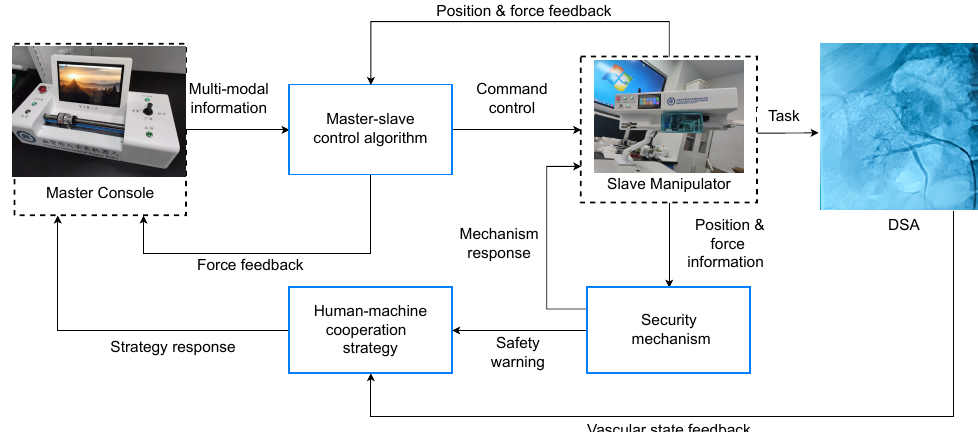
Figure 1. Control flow of the VISR. Surgeons teleoperate the doctor’s terminal in the room without X-rays, and the slave manipulator with a robotic arm is placed beside the patient’s bed. Distributed Application (Shared control optional)